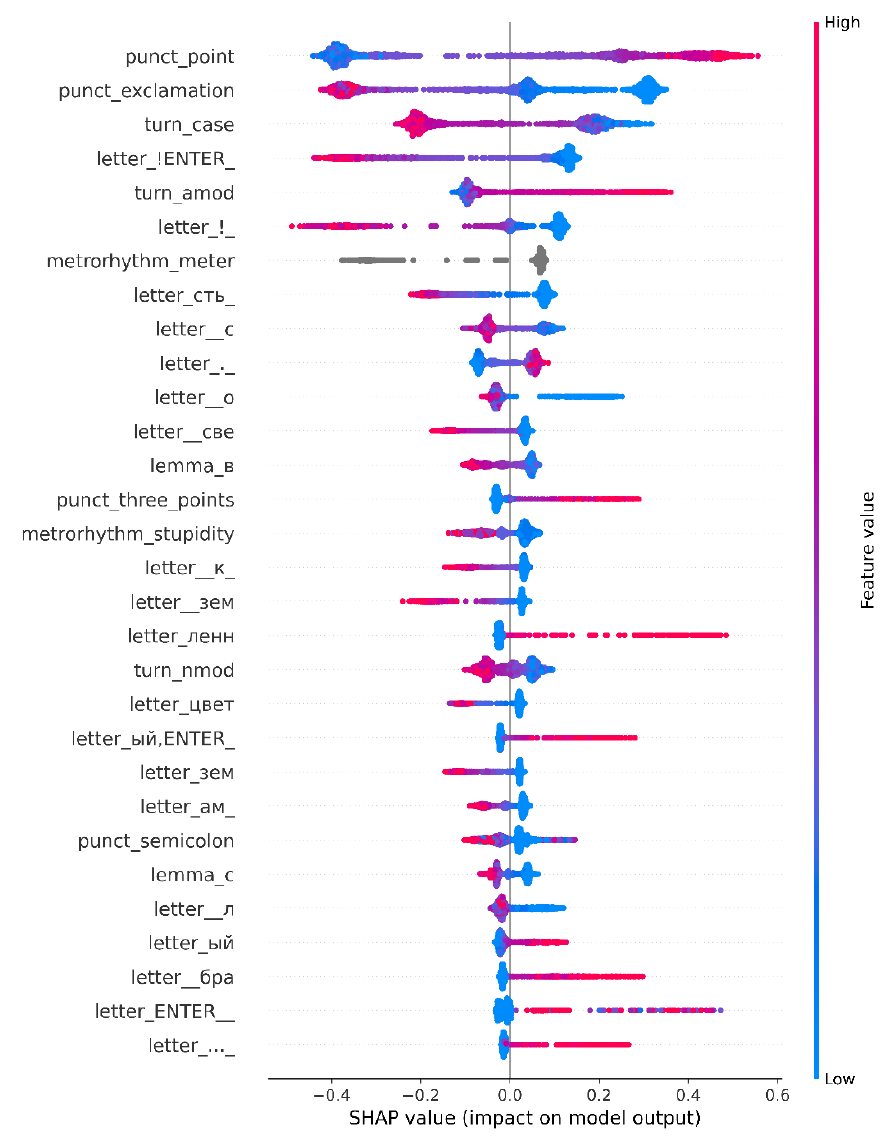
Figure 5. The distribution of the influence of features on the results of classification by feature groups.